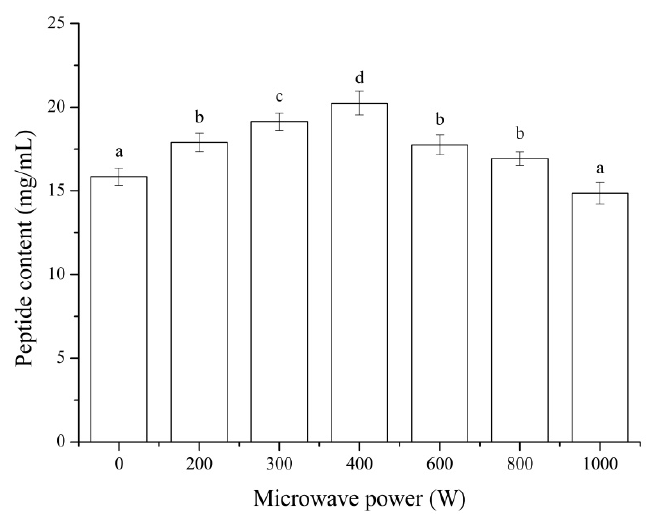
Figure 5. Peptide content of MP hydrolysate after pretreated by microwave. Results represent the means of three determinations ± standard deviation. Means with different superscripts (a, b, c, d) are significantly different ( p < 0.05).